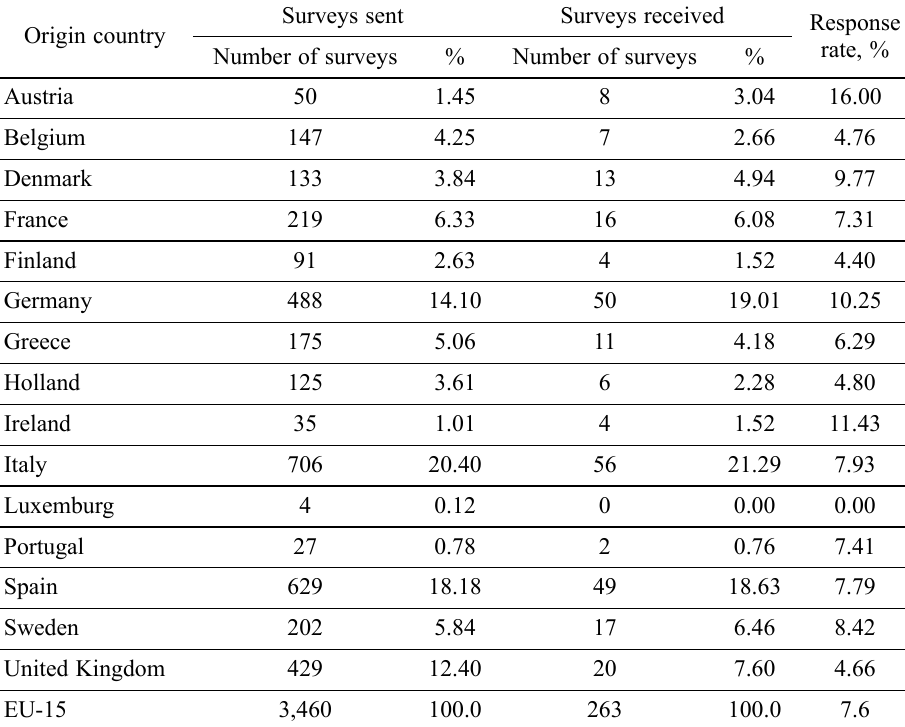
Table 1. Distribution of responses received, by country of